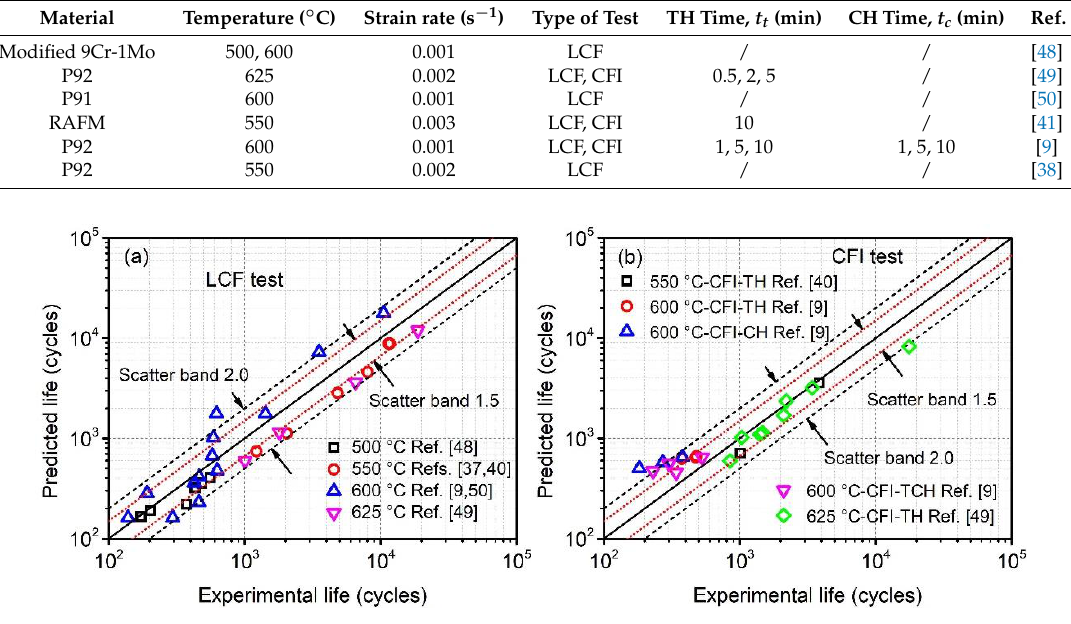
Figure 11. Comparison between experimental life from [9,38,41,48–50] and predicted life using MMCB model at ( a ) LCF and ( b ) CFI loadings.